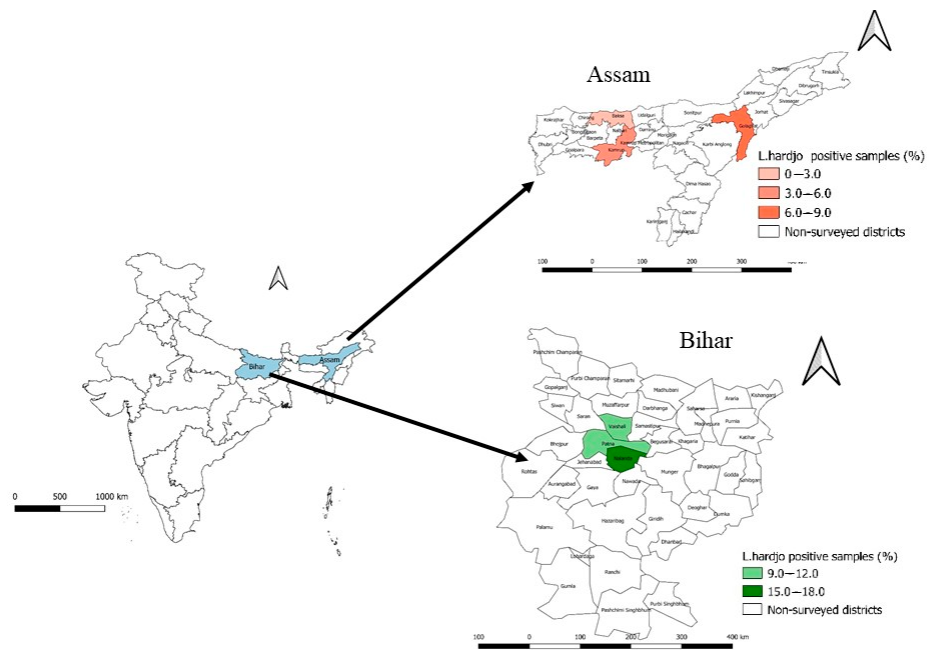
Figure 1. Seroprevalence for L. serovar Hardjo on dairy farms in the states of Bihar and Assam, India. Of the 680 blood samples tested, results from the L. Hardjo Ab. indirect